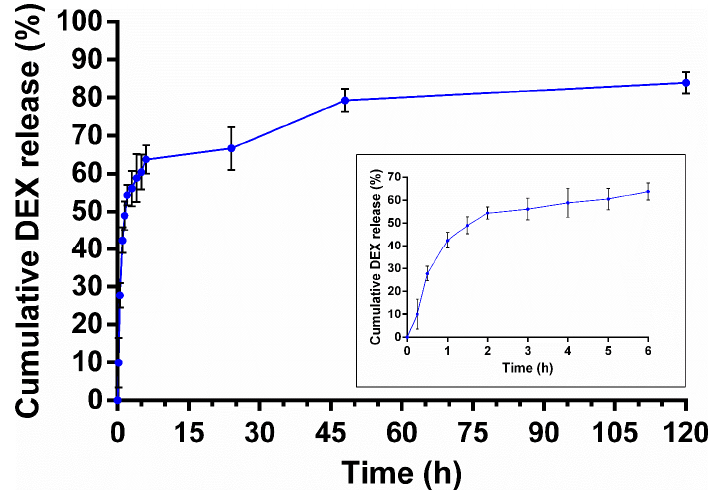
Figure 10. In vitro DEX release from PLGA NPs (pH 7.4, 37 °C). Inset shows the drug release profile over the initial 24 h. Values are mean ± s.d. of four experiments.